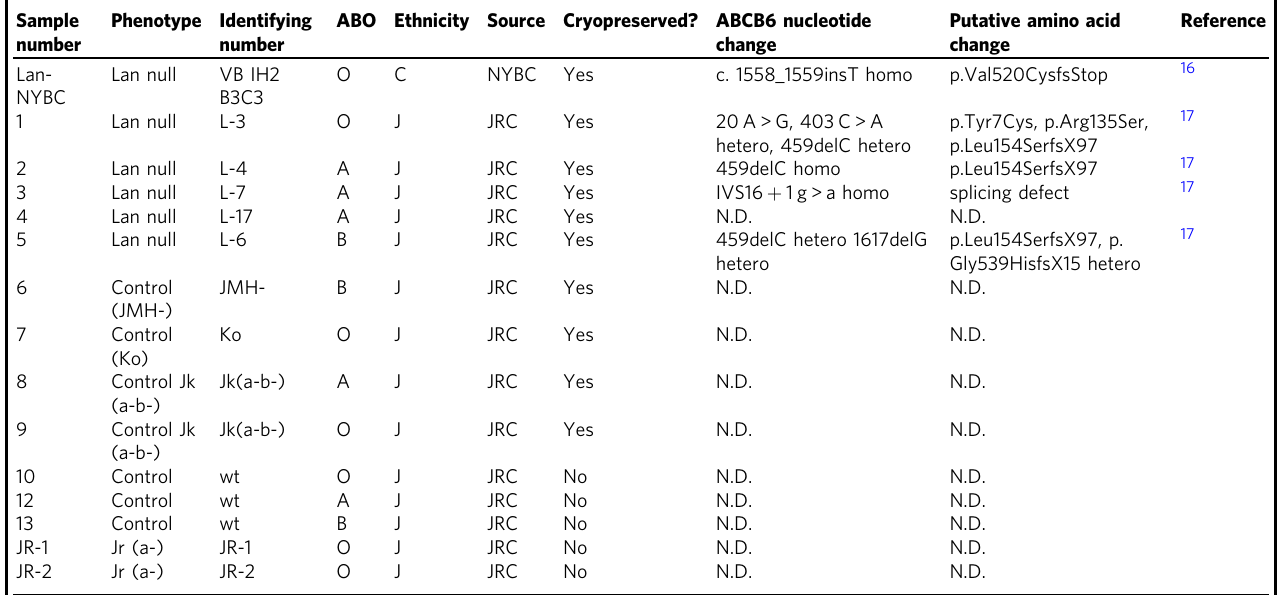
Table 1 Lan null and control samples used in this